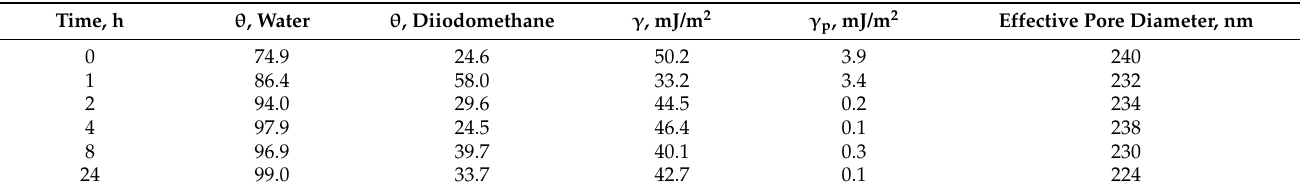
Table 2. Change in effective pore diameter and contact angle of membrane depending on the time of reaction with TCOS (at a constant concentration of 15